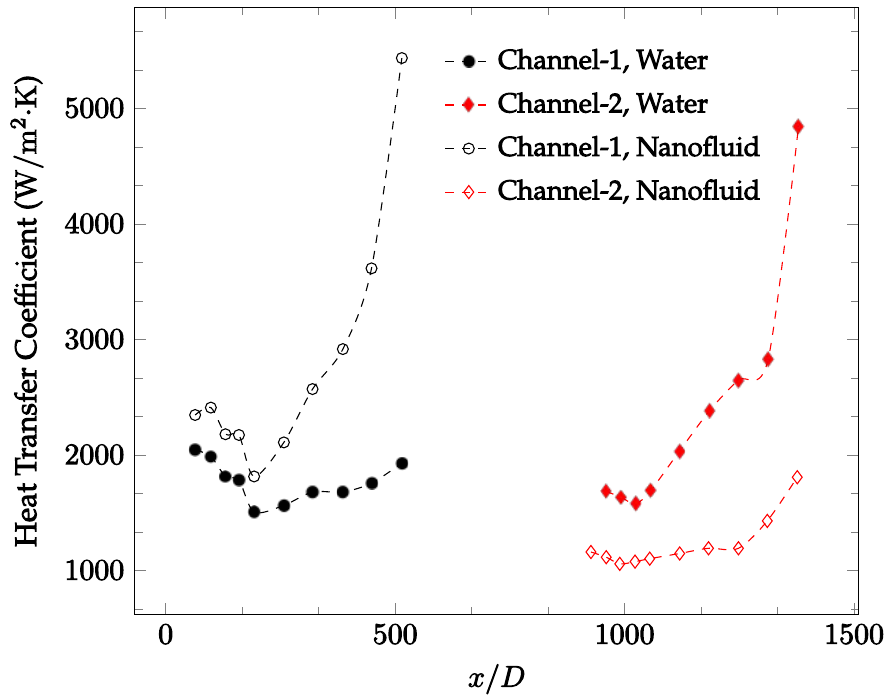
Figure 21. Change in convective heat transfer coefficient of deionized water and Fe 3 O 4 -deionized water nanofluids as a function of dimensionless distance for a Reynolds number of 100–114. The nanoparticle concentration was 1% by weight. A converging nozzle is used as a connector.